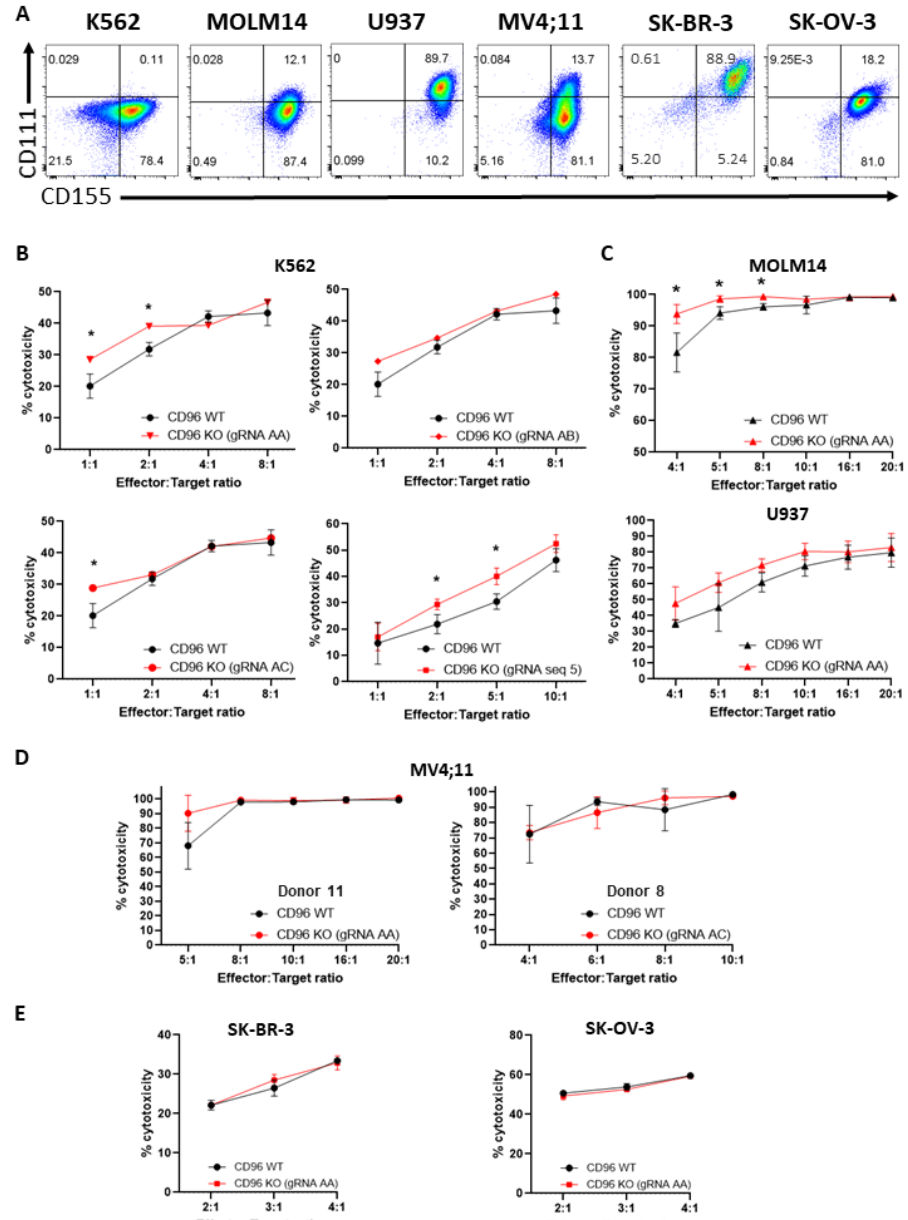
Figure 2. CD96 deficiency in T cells enhances T cell cytotoxicity against K562 and MOLM14 cells. ( A ) Expression of CD96 ligands, CD155 and CD111, on K562, MOLM14, U937, MV4;11, SK-BR-3, and SK-OV-3 cells as assessed by flow cytometry. Quadrant gates were applied based on no staining for CD155 and CD111. ( B ) Percentage (%) cytotoxicity of T cells (calculated as described in Materials and Methods) against luciferase-expressing K562 cells 20 h following co-incubation of T and K562 cells at indicated E:T ratios. Each graph depicts T cells that were electroporated with different gRNAs. ( C ) % cytotoxicity of T cells against luciferase-expressing MOLM14 (top) and U937 (bottom) co- cultured with T cells as in ( B ). ( D ) % cytotoxicity of T cells, derived from 2 different human donors, against luciferase-expressing MV4;11 cells co-cultured with T cells as in ( B ). ( E ) % cytotoxicity of T cells against luciferase-expressing SK-BR-3 (left) and SK-OV-3 (right) co-cultured with T cells as in ( B ). Data in ( B – E ) are the mean ± SD of 3 technical replicates; multiple unpaired Student’s t -tests, *, p < 0.05. All data are representative of 2 independent